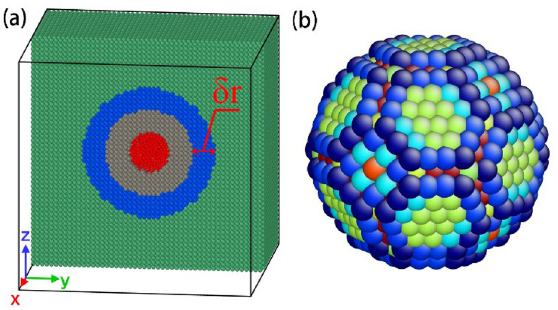
Figure 1. A helium bubble-embedded tungsten model ( a ) and the configuration of the nearest tungsten atoms surrounding the bubble ( b ). A spherical shell with thickness of δ r is marked in dashed red circle, which is set to evaluate the average